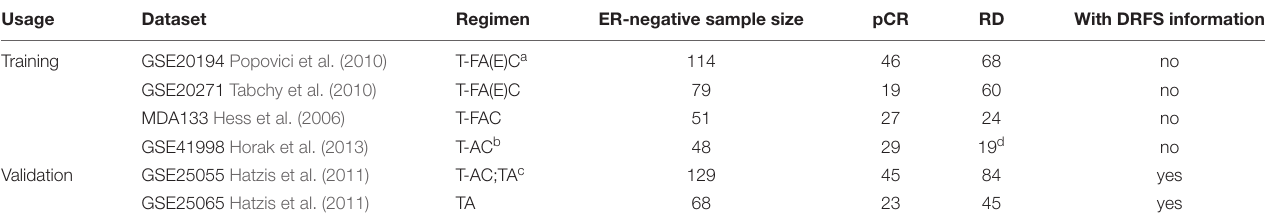
TABLE 1 | Description of all datasets collected in this